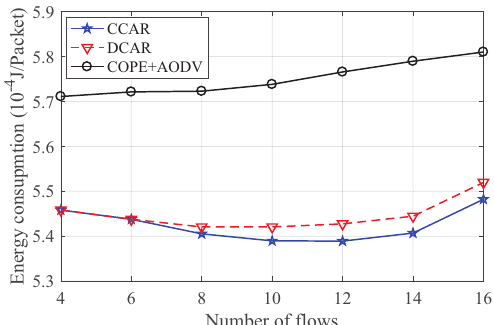
Figure 16. Energy consumption versus flow number in the grid